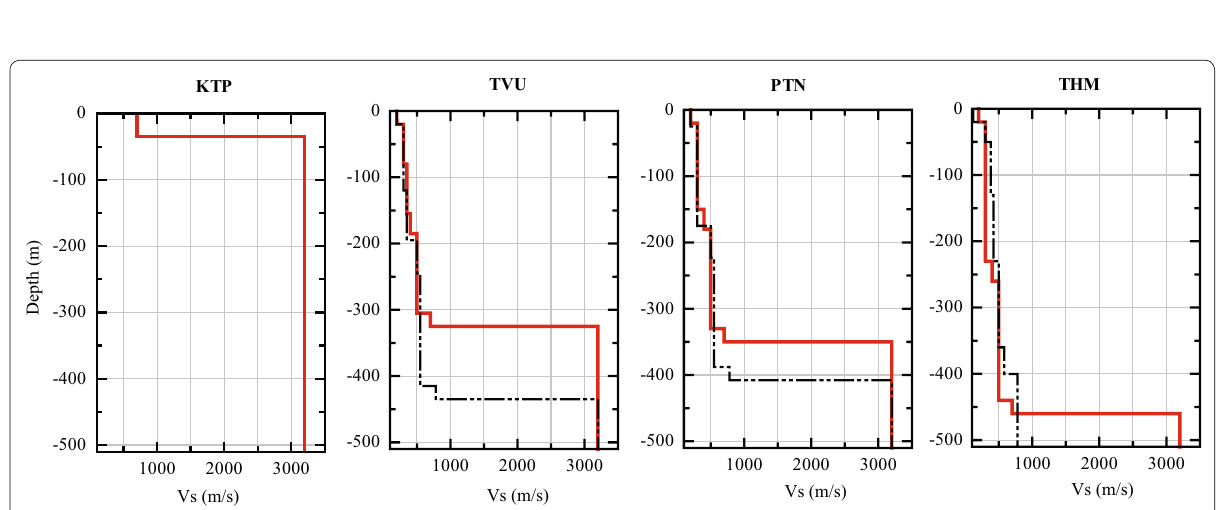
Fig. 7 Comparison between simulated and observed waveforms for the mb4.9 earthquake. Also shown is the result using the initial model, in gray . Waveform matching was conducted using trial and error for time windows indicated by the red arrows